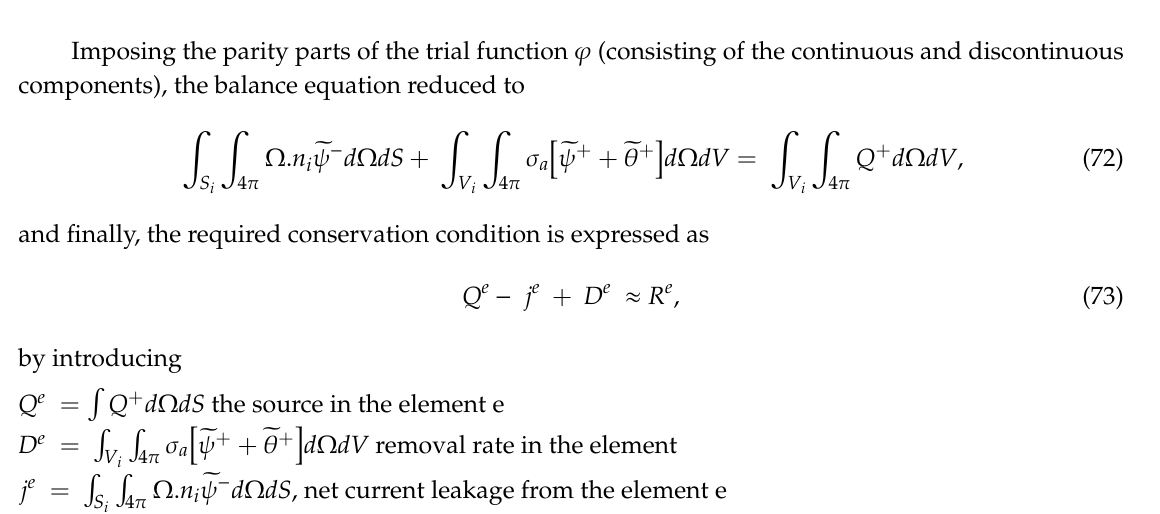
Table 7. Errors of the entire domain for various angular approximations.